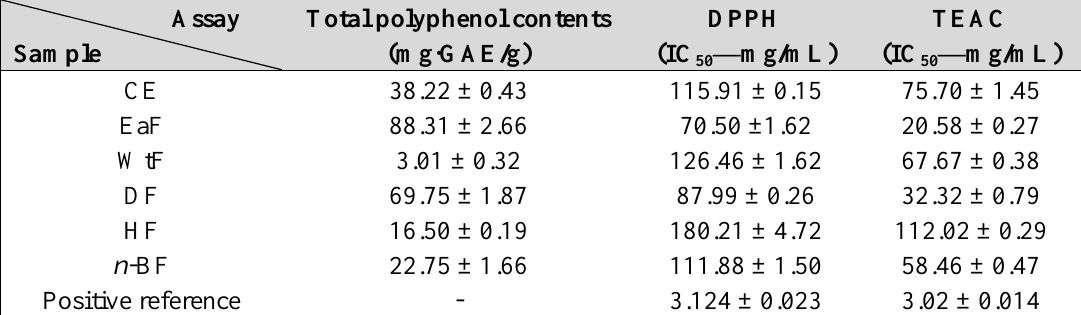
Table 3. Total polyphenol contents, DPPH radical scavenging activity and Trolox equivalent antioxidant capacity (TEAC) of Sida